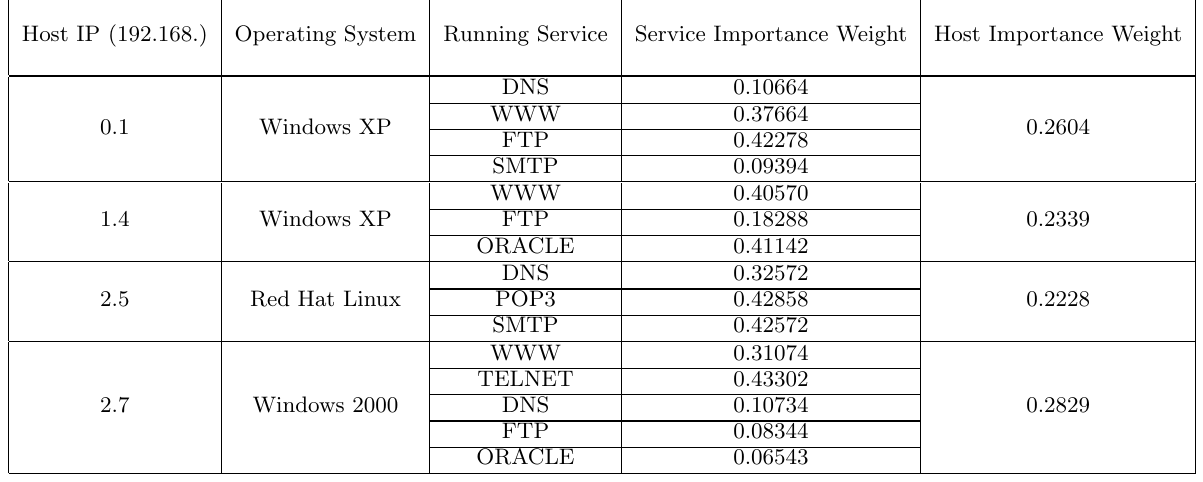
Table 3: Network Con(cid:12)guration and the Distribution of the Weight Host IP (192.168.)